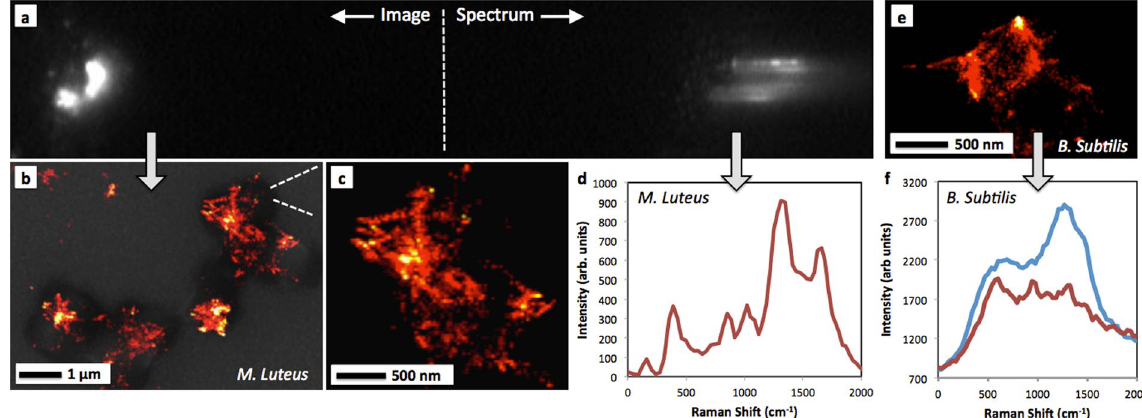
Figure 4. Depiction of the “snapshot” chemical imaging process by imaging through a diffraction grating. ( a ) One frame of the SERS blinking video showing the zeroth order (undiffracted) image and the diffracted spectra from each blink. This image was saturated to show both the zero order light and the weaker spectrum in the same frame. ( b ) SERS-STORM image of an M. Luteus sample overlaid on an SEM image of the same cells. ( c ) Blown-up region showing < 50 nm details, demonstrating that the diffraction grating does not degrade the image quality. ( d ) A sample spectrum extracted from the SERS-STORM image. ( e ) Zoomed in image of a B. Subtilis sample. ( f ) Two spectra have been extracted from the SERS-STORM data giving peaks at similar locations to those shown by the traditional